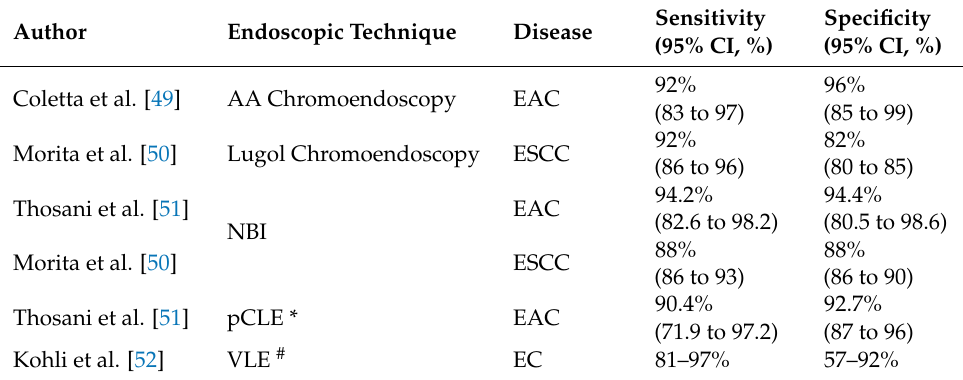
Table 2. Performance of advanced endoscopic imaging in the diagnosis of esophageal cancer accord- ing to systematic reviews and